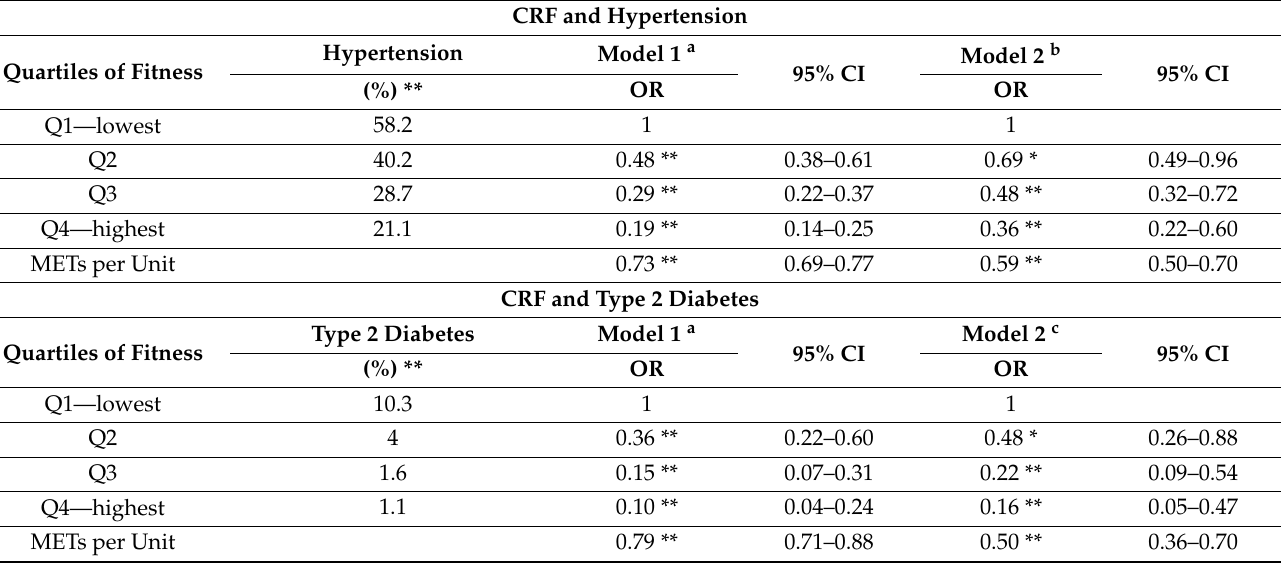
Table 3. Association between CRF (in METs) and presence of cardiometabolic risk